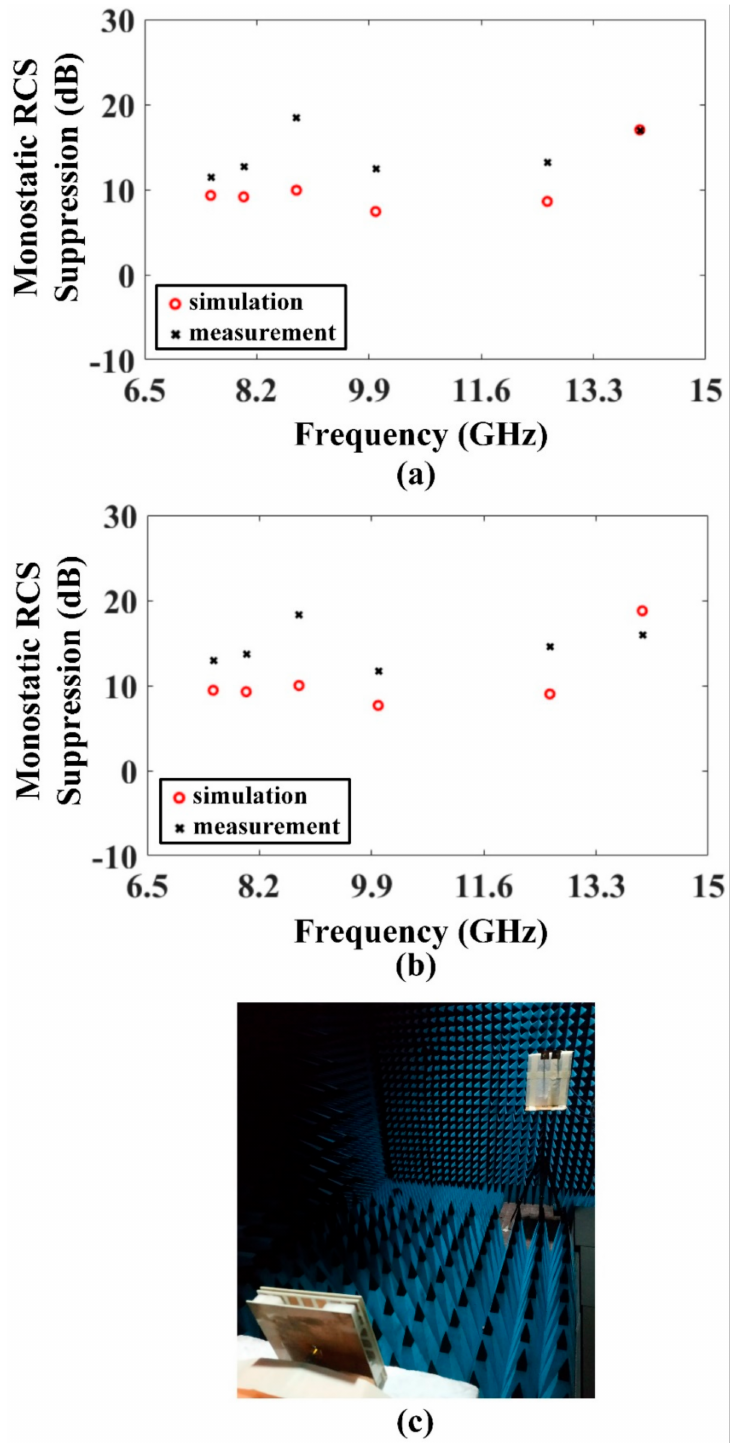
Figure 9. Simulation vs. measurement results of monostatic RCS suppression presented at different frequency points. ( a ) VP wave incidence. ( b ) HP wave incidence. ( c ) Measurement